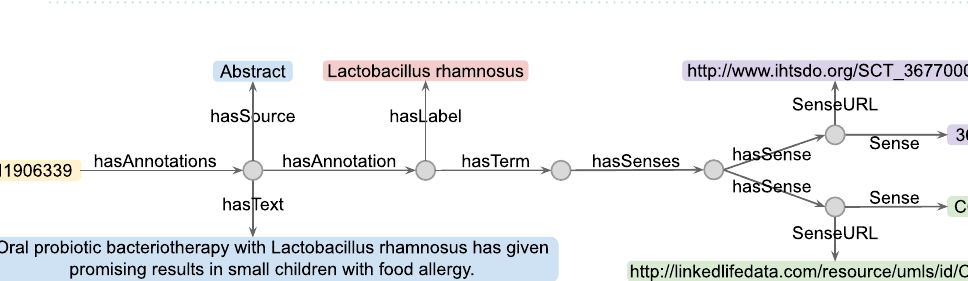
Table 1. Hierarchical overview of annotations in the ppstatement knowledge base.